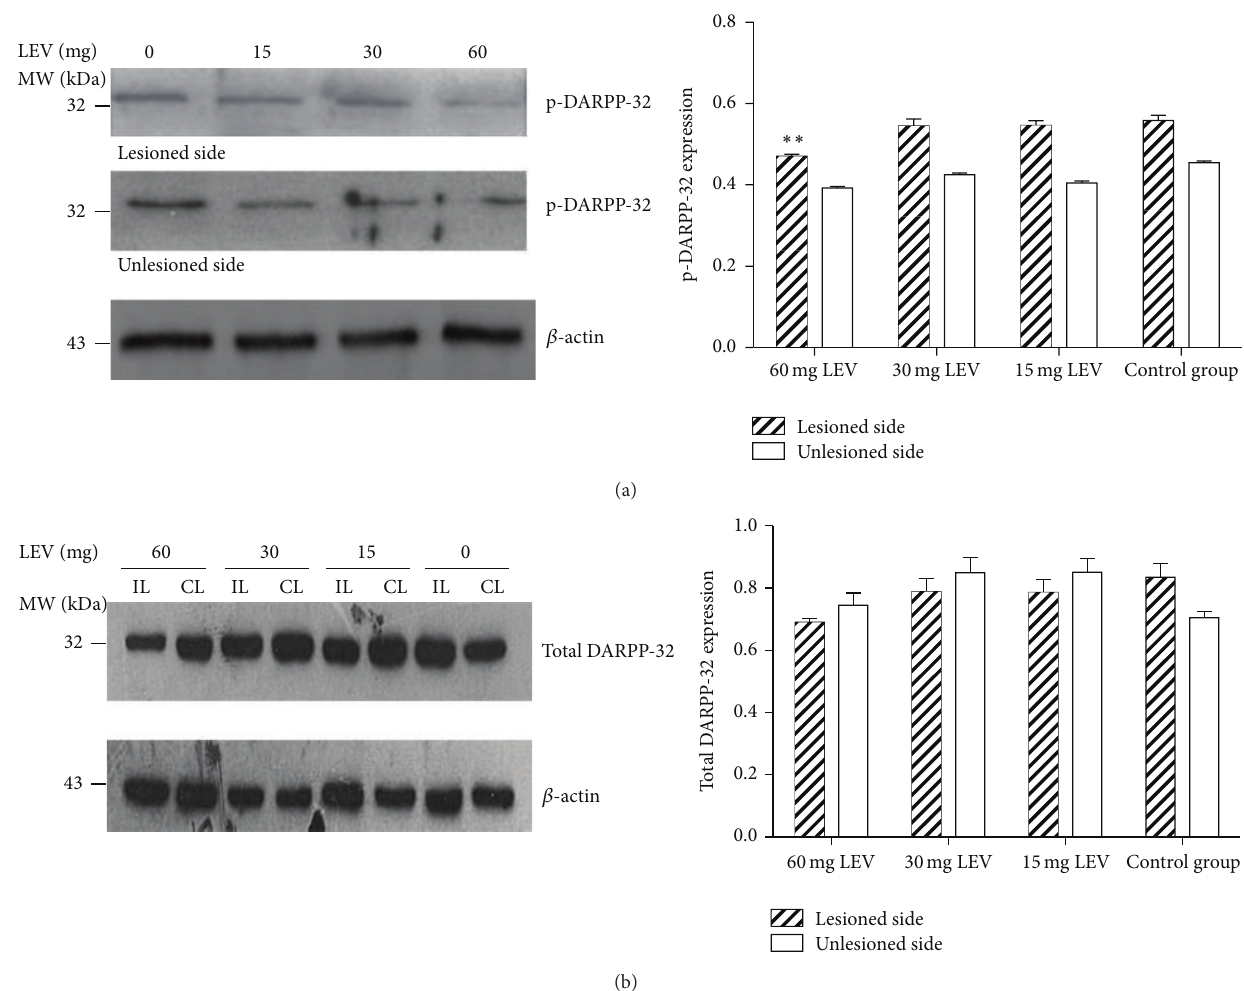
Figure 4: Levetiracetam-induced changes in the phosphorylation of DARPP-32 in the dorsolateral portion of the striatum. (a) Images display immunoblots from striatal tissue (lesioned and unlesioned side) from one animal in each levetiracetam treatment group. Immunoblots correspond to p-DARPP-32 and 𝛽 -actin as internal control. The graph compares p-DARPP-32 expression across treatment groups. Levetiracetam 60 mg/kg significantly reduced the striatal p-DARPP-32 expression. ∗∗ 𝑃 < 0.01 versus same side of the control group. (b) Images display immunoblots from striatal tissue (IL: ipsilateral side; CL: contralateral side) from one animal in each levetiracetam treatment group. Immunoblots correspond to total DARPP-32 and 𝛽 -actin as internal control. The graph compares total DARPP-32 expression across treatment groups. Levetiracetam had nonsignificant effects on the striatal total DARPP-32 expression ( 𝑛 = 6 per group; LEV: